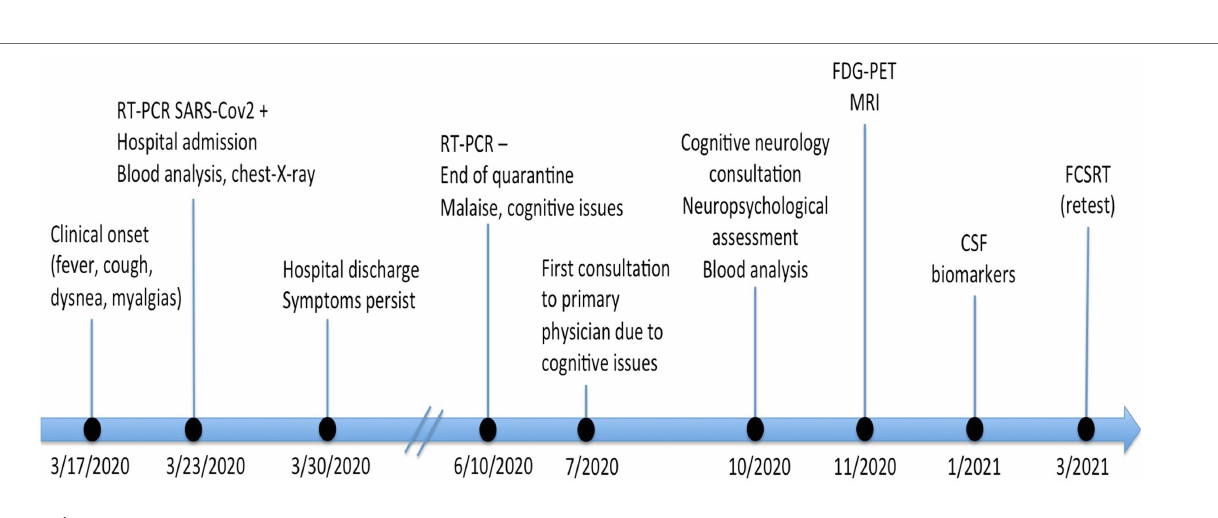
FIGURE 2 | Timeline of events and tests for the case